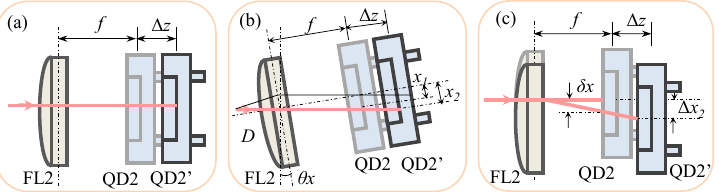
Figure 5. Effect of the position offset on the measurement accuracy ( a ) without the angular error, ( b ) with the angular error and ( c ) with the straightness error.